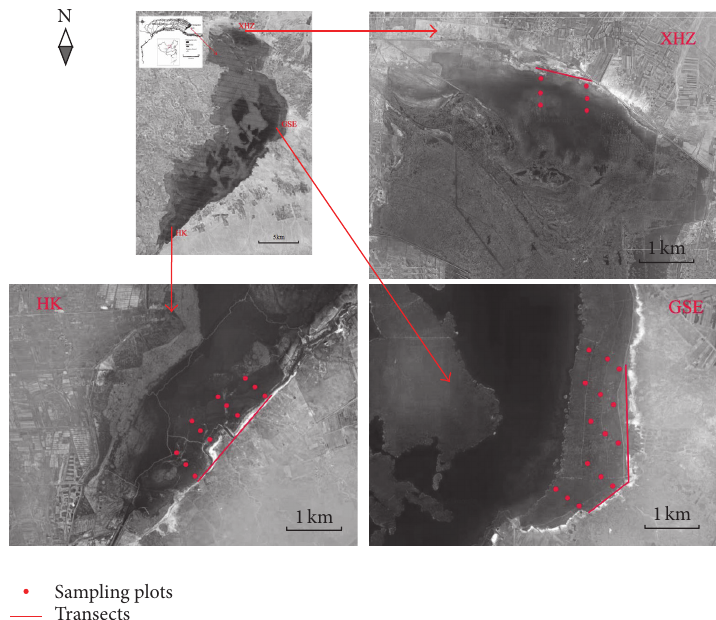
Figure 1: Location of Wuliangsuhai Lake and the arrangement of shorebird survey transects (lines) and sampling plots for macroinvertebrates and environmental variables (dots) within the study areas of Gesuer (GSE), Hekou (HK), and Xiaohaizi